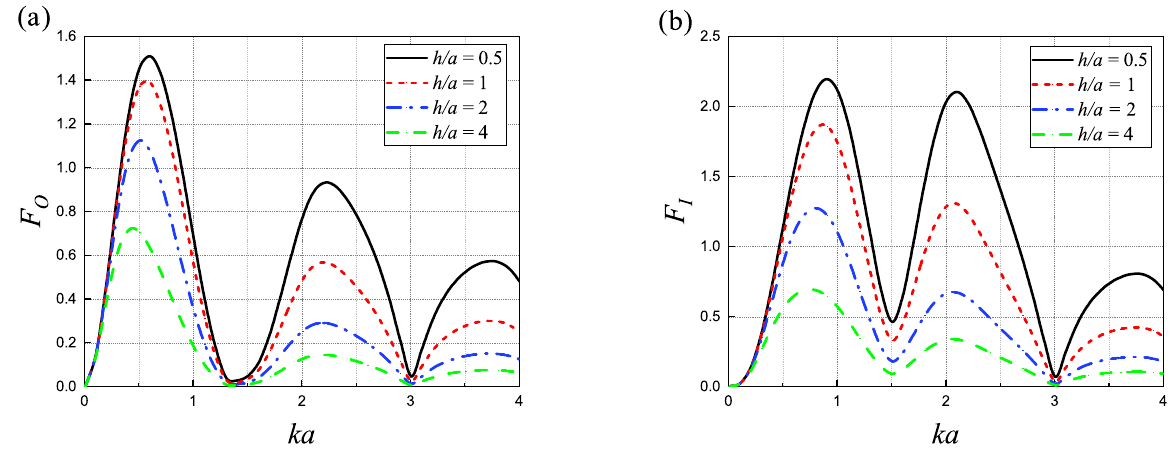
Figure 11. Hydrodynamic forces on the outer and inner cylinders versus ka for different values of h / a with e / a = 1, G 1 = 1, β = 0, and c / a = 0.5 : ( a ) the outer cylinder, ( b ) the inner